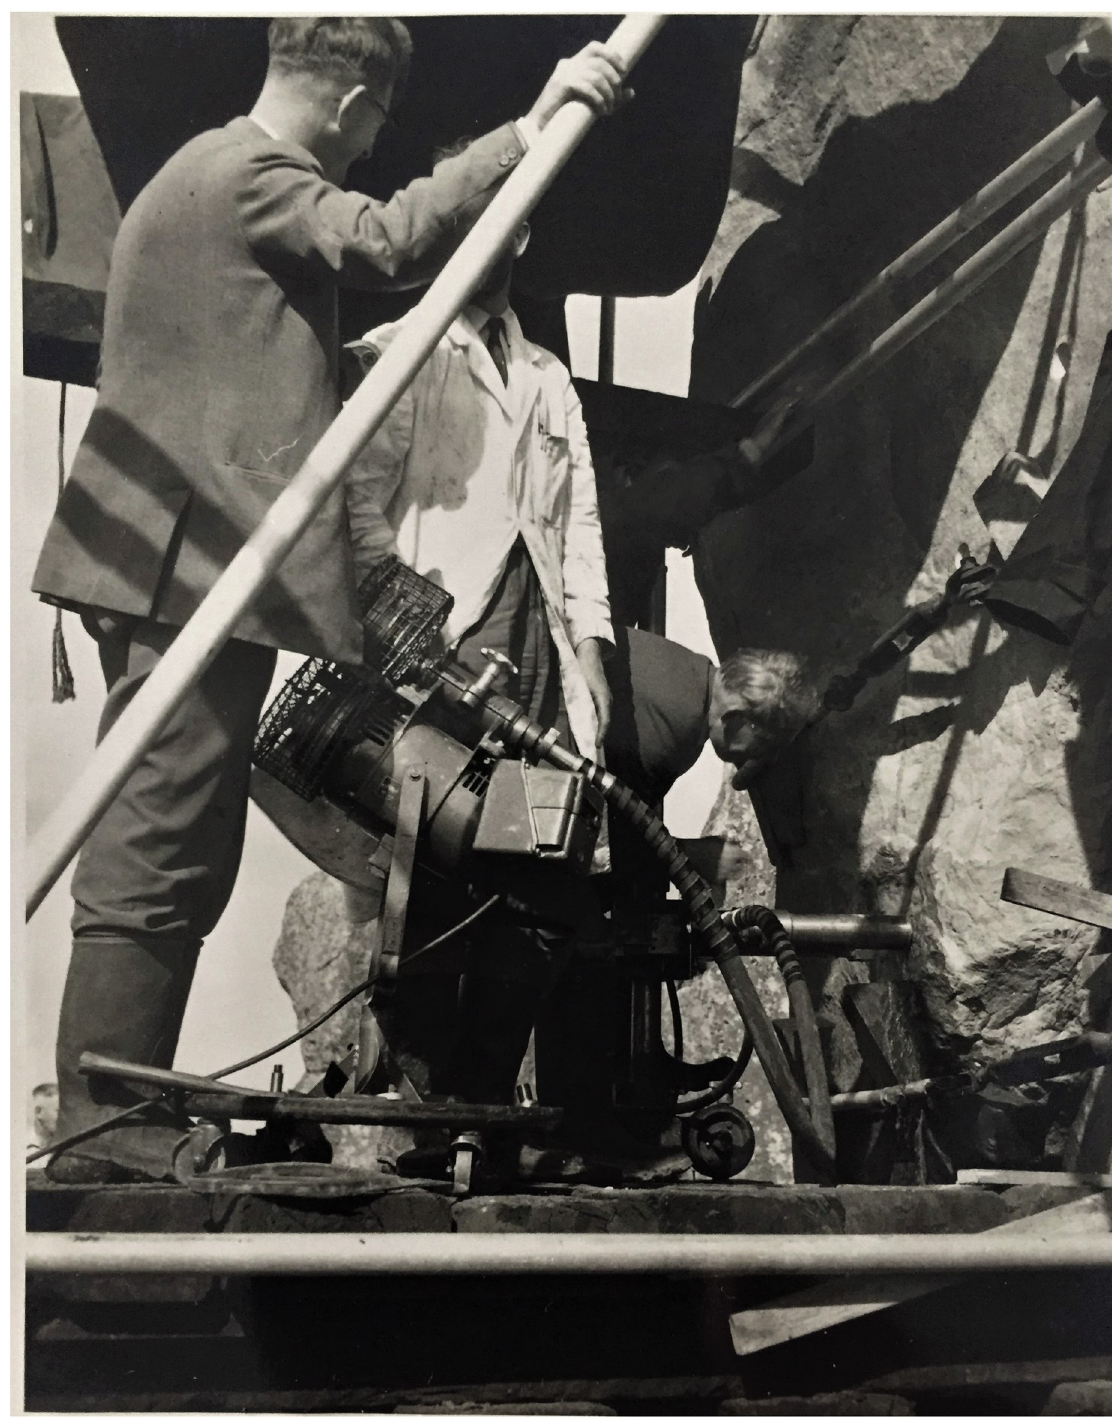
Fig 2. Drilling work on Stone 58 at Stonehenge by Van Moppes Ltd in August 1958, with Mr Robert Phillips pictured left. Permission was obtained from Mr Lewis Phillips for the image of his late father to appear in this picture and for him to be identified by name. This image is reproduced under a CC BY 4.0 license, with permission from Lewis Phillips, original copyright (2020).